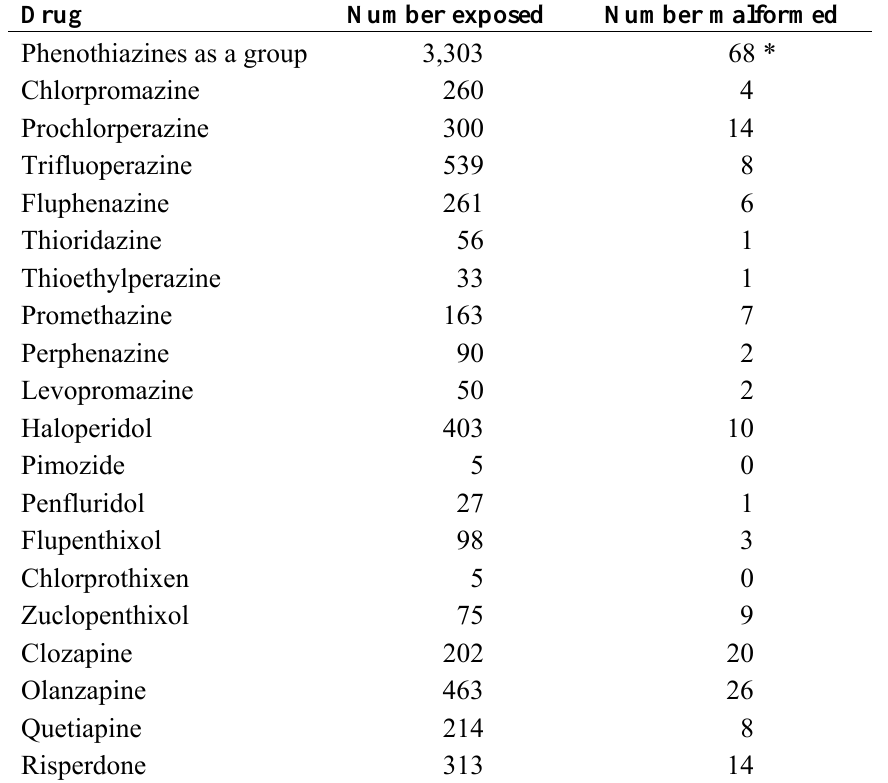
Table 17. Summary of literature on neuroleptics according to the review by Gentile [67].